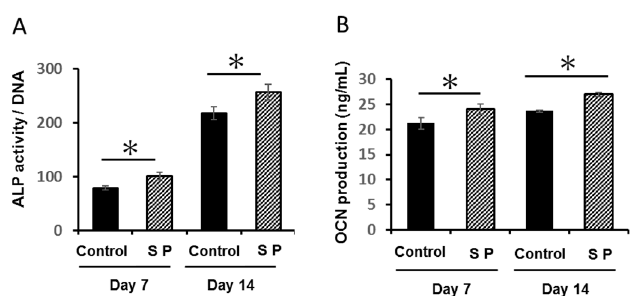
Figure 2. Effect of synthetic amelogenin exon 5 encoded peptide (SP) on DPSCs in osteogenic differentiation and mineralization. Confluent DPSCs were cultured with osteogenic medium and SP (0, 100 ng/mL) for 7 and 14 days (* P < 0.05). ( A ) alkaline phosphatase (ALP) activity and ( B ) osteocalcin (OCN) production ( A , B ).